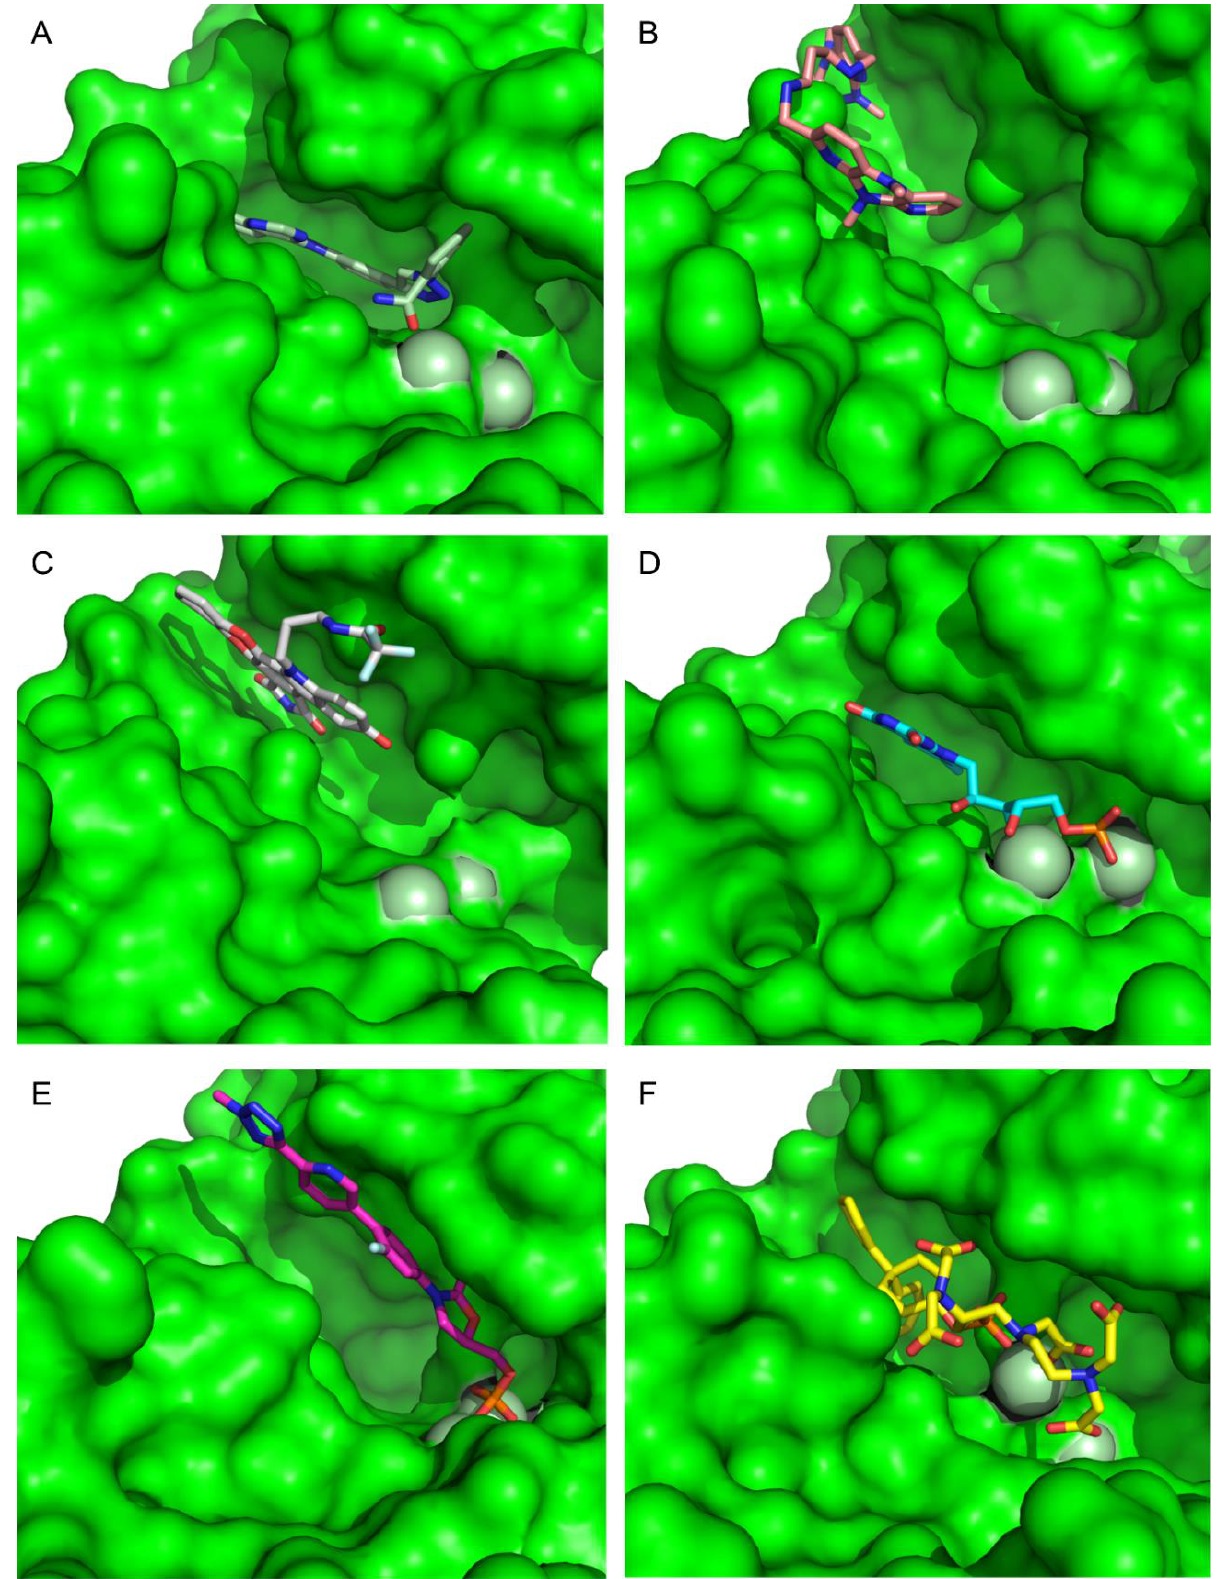
Figure 9. Surface representation of CMLDID2468 ( A ), AB-00011214 ( B ), AB-00014564 ( C ), Riboflavin Monophosphate ( D ), Tedizolid Phosphate ( E ) and Gadofosvese ( F ) bound to PknB. Figures were produced using Pymol.